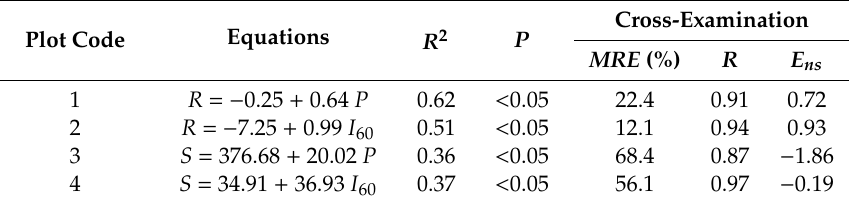
Table 5. Regression model of runo ff and sediment yield. Plot Code